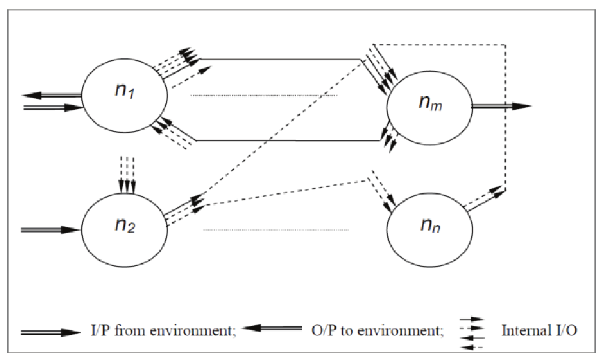
Fig. 2. Internal computational structures of